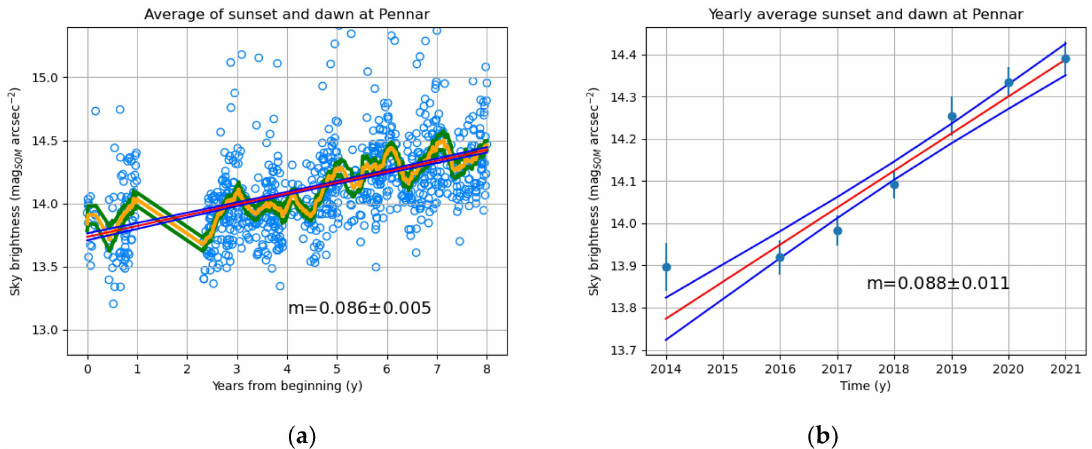
Figure 9. Trends of the sky brightness at zenith at Pennar: average values at sunset and dawn ( a ) with their moving average (yellow curve) and aside the green curves accounting for one standard deviation ( a ) and the annual average values ( b ) when the Sun altitude is around − 6.5 ◦ , the red line is the linear fitting and the blue curves account for the uncertainty on the fitting parameters.